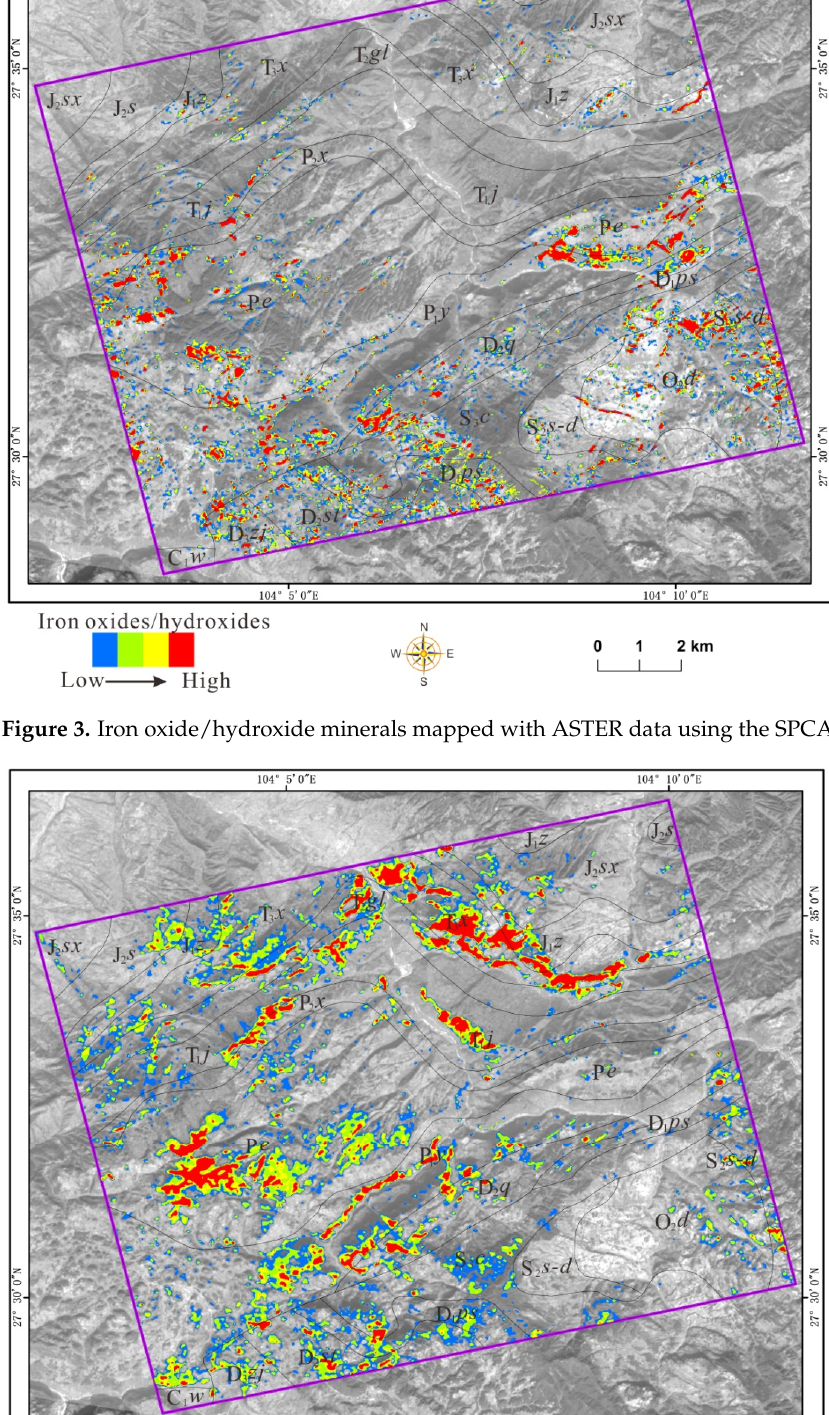
Table 3. Eigenvector matrix of the argillic minerals calculated using the SPCA method for ASTER bands 4, 5, and 6.